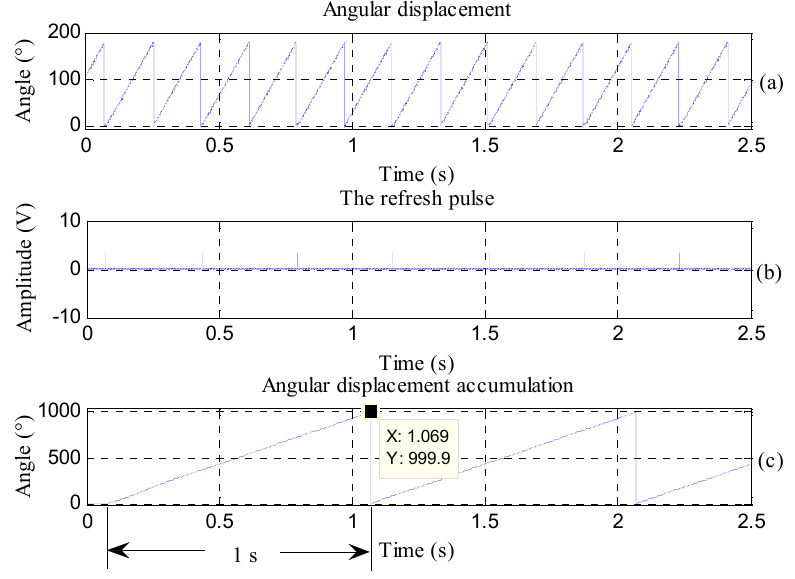
Figure 11. Accumulative calculation graph of angular displacement at 1000 ◦ /s.